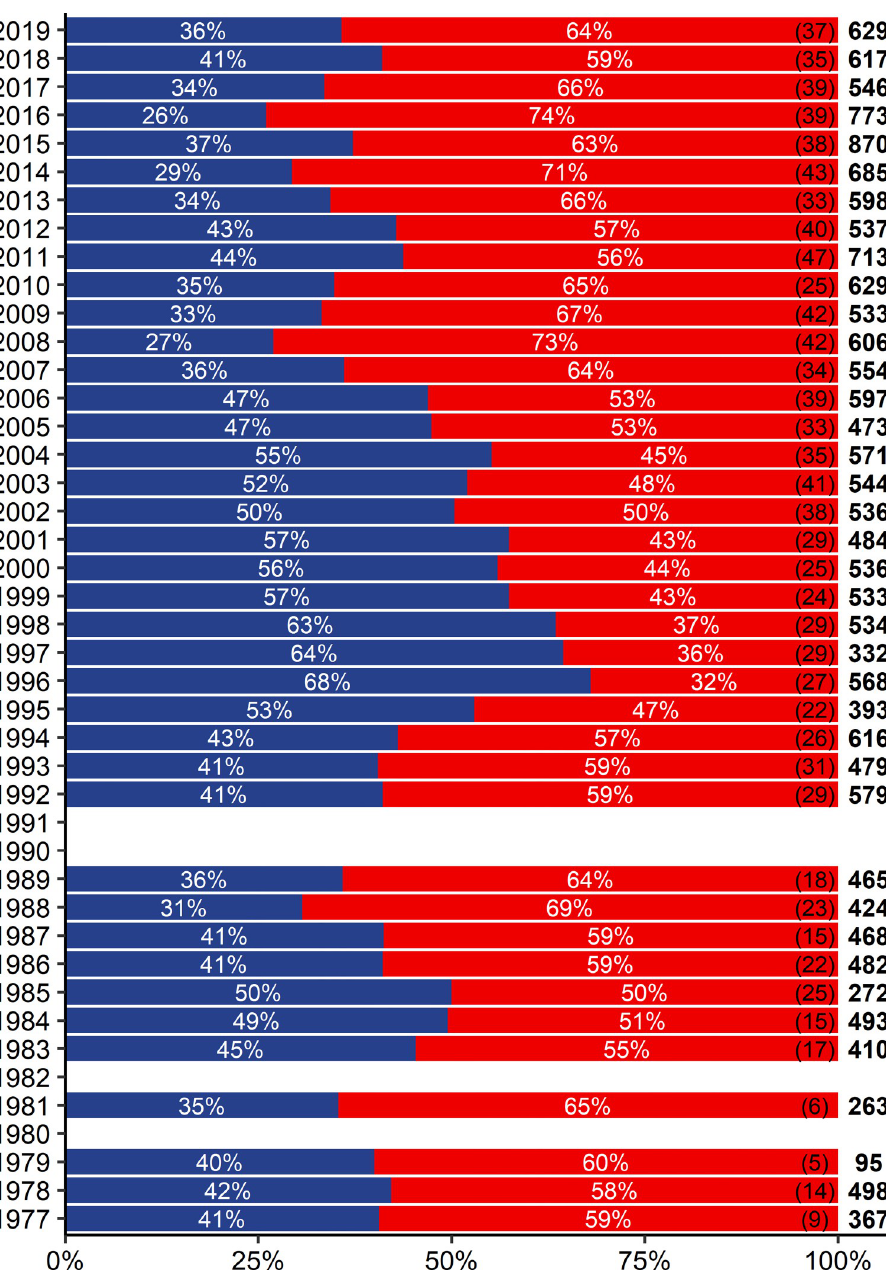
in passive gears catches were consistent irrespective of the fishing gear (i.e. gillnets or long- lines). Estimated mixing proportions based on commercial cod samples from active gear fish- eries were generally in line with the estimates based on survey cod sampled during scientific trawl surveys (Fig 2).